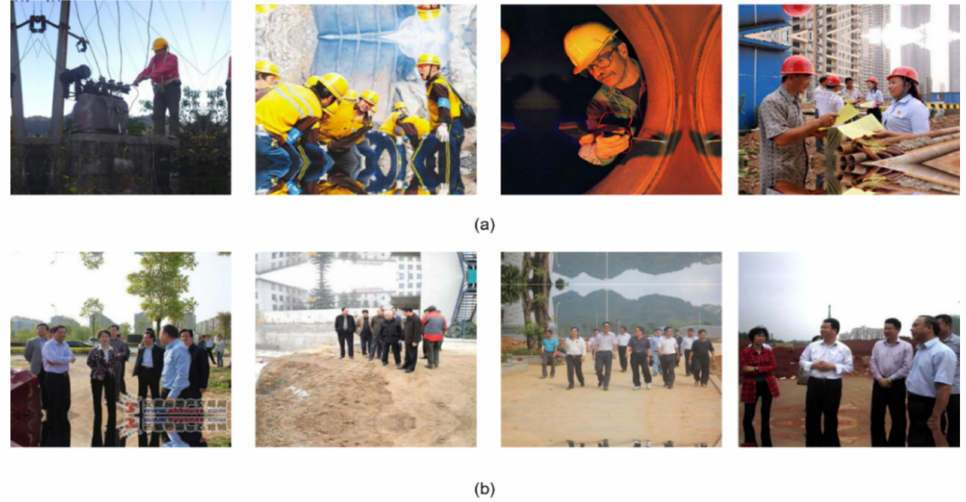
Figure 3. Examples of Construction Site images of people ( a ) Wearing Helmets ( b ) Not Wearing